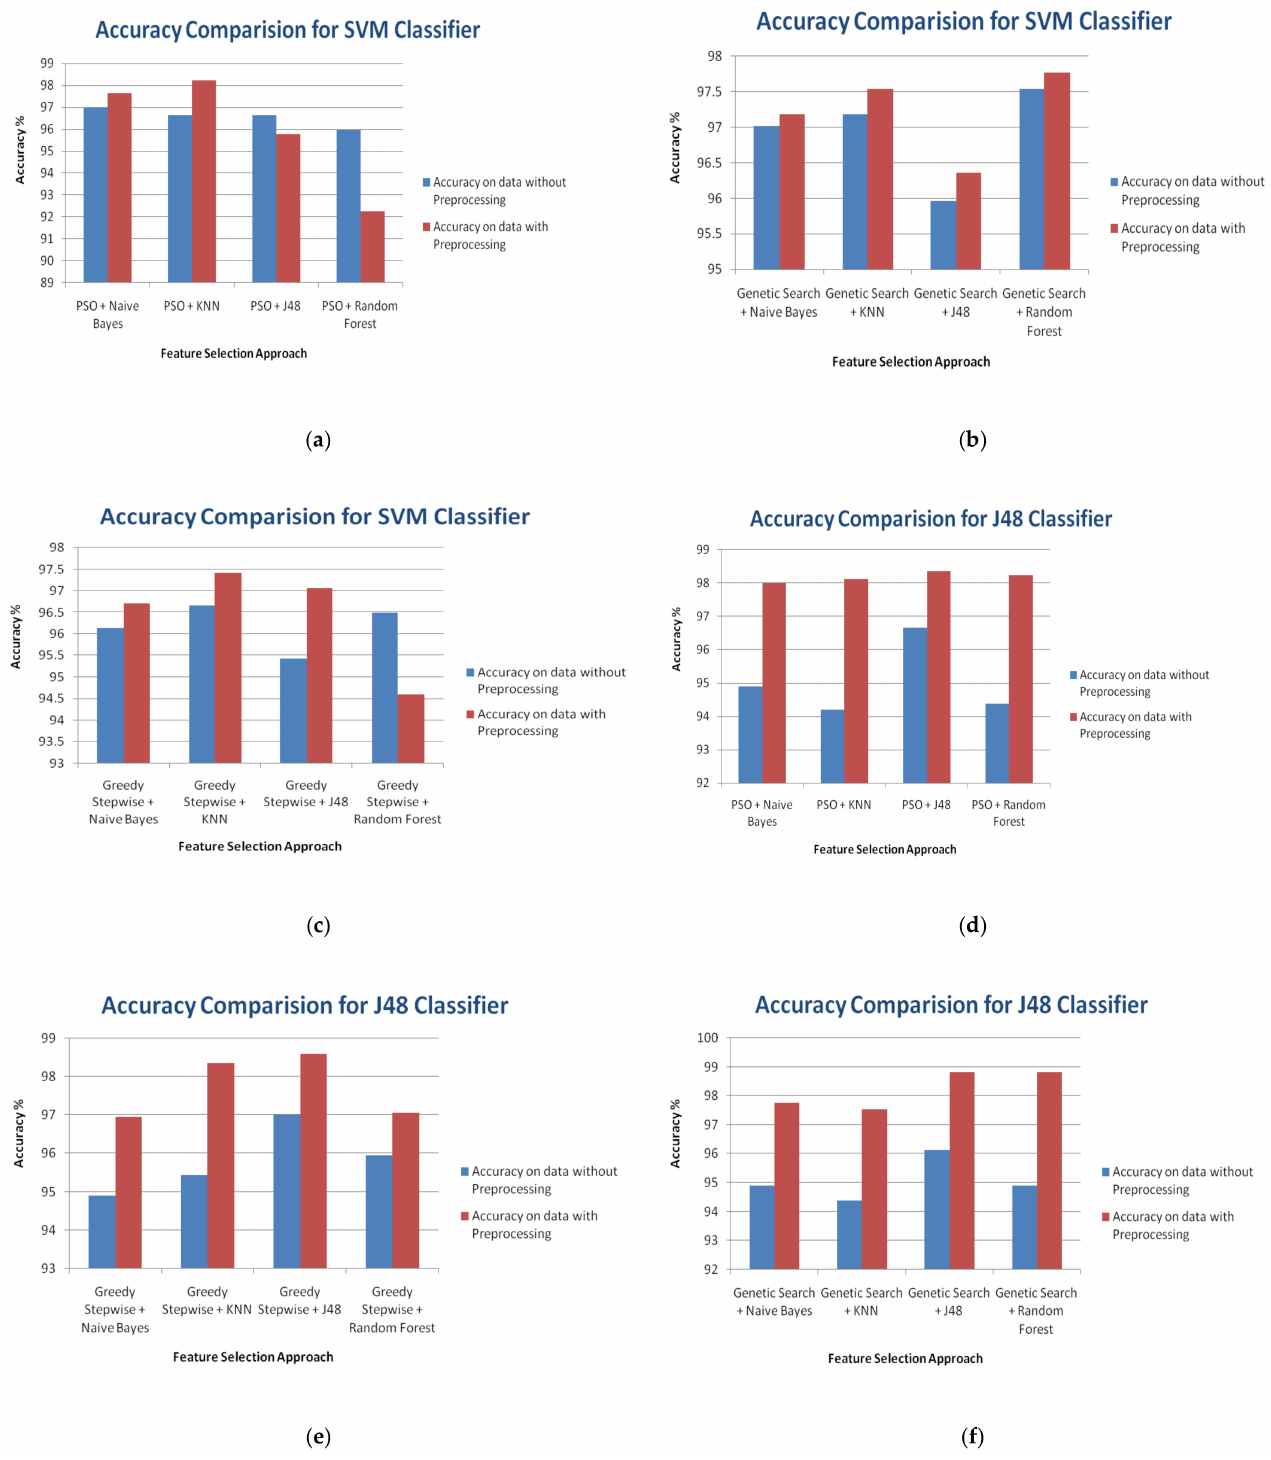
Figure 5. Accuracy comparison of support vector machine (SVM) for ( a ) PSO features selection algorithm; ( b ) Genetic Search features selection algorithm; ( c ) Greedy Stepwise features selection algorithm; ( d ) Accuracy comparison of J48 for PSO